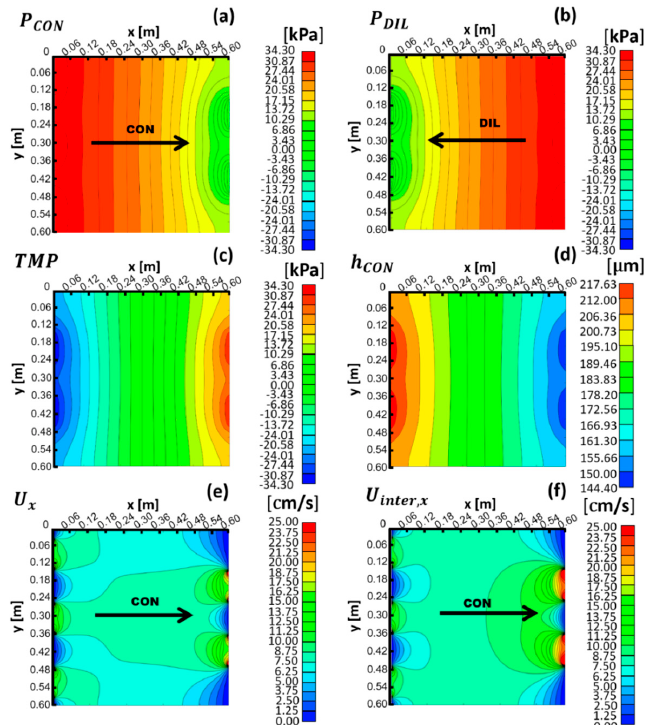
Figure 16. Results for a cross flow stack of 0.6-m sides at (cid:104) U s (cid:105) = 7.5 cm / s in the presence of membrane deformation: maps of relative pressure in the CON ( a ) and DIL ( b ) channels; TMP ( c ); and channel equivalent height ( d ), superficial velocity ( e ), and interstitial velocity ( f ) along the x direction in the concentrate channel.